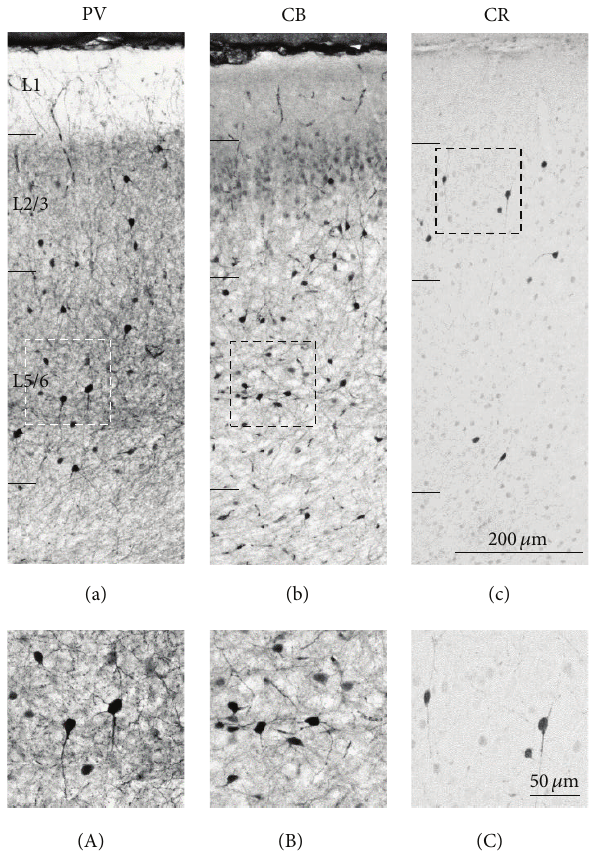
Figure 2: Localization of interneuron in the mouse PFC. Represen- tative light micrograph showing laminar distribution of PV (a), CB (b), and CR (c) neurons in the PL. (a) PV neurons are located in L2/3 and L5/6. (b) CB neurons are mainly located in L2/3 and L5/6. The principal neurons in L2 are weakly immunopositive to CB. (c) CR neurons are mainly located in L2/3. (A)–(C) Higher magnification images of interneurons in the PL. Scale bars = 200 𝜇 m in (c) (applies to (a)–(c)); 50 𝜇 m in (C) (applies to